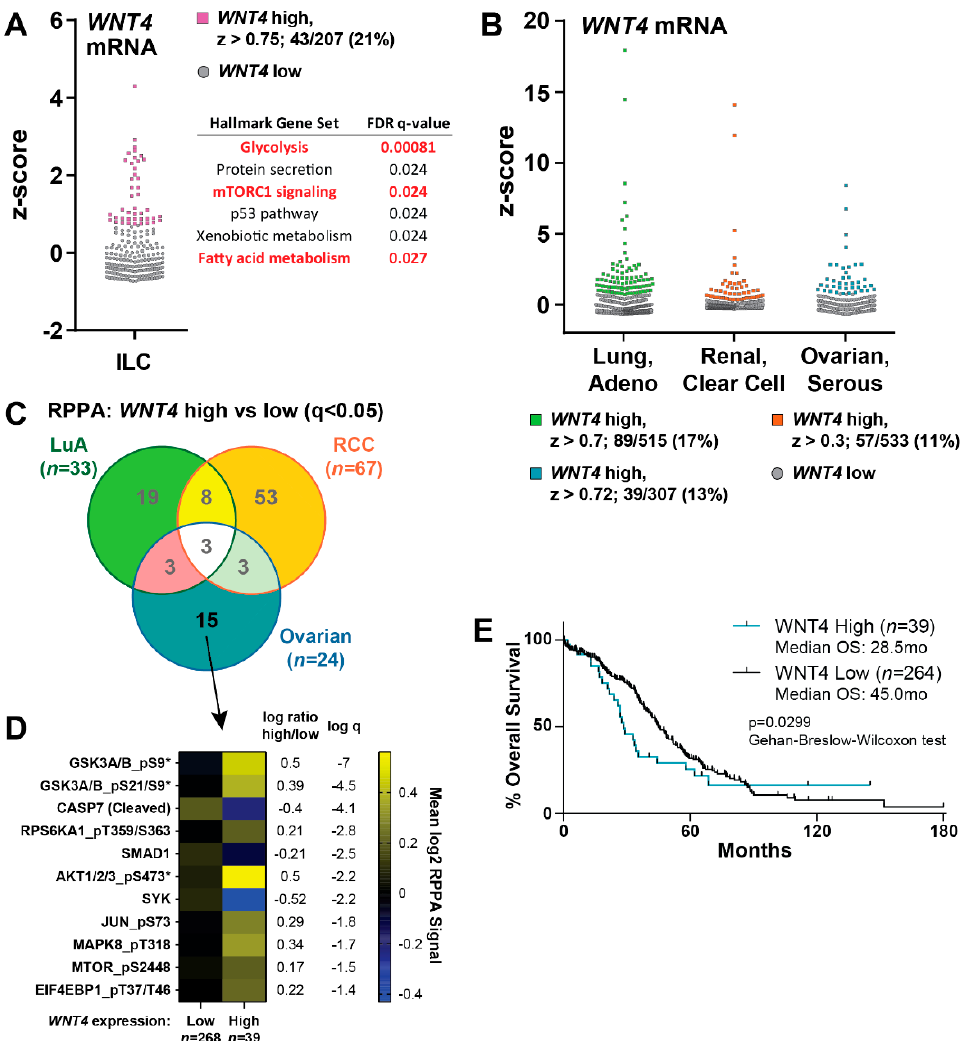
Figure 6. High WNT4 expression is associated with activated mTOR signaling in ILC and serous ovarian cancer. ( A ) RNAseq z-scores used to identify tumors with high WNT4 mRNA levels from The Cancer Genome Atlas (TCGA) data. Points represent individual tumor samples; colored v gray points represent individual tumor samples with high / low WNT4. n = 354 genes di ff erentially expressed in WNT4-high vs. -low tumors were analyzed against the MSigDB “Hallmark” genesets. ( B ) RNAseq z-scores were used to identify WNT4-high vs. -low tumors as in ( A ). ( C ) cBio “Enrichment” tool was used to identify di ff erences in RPPA signals for WNT4-high vs. -low tumors (q < 0.05). ( D ) Mean log2 RPPA signal for WNT4-associated RPPA targets specific to OvCa. *, GSK3A / B and AKT1 / 2 / 3 are counted as individual targets in cBio but do not have unique data ( n = 15 from Venn yields n = 11 unique targets). ( E ) Overall survival data derived from cBio “Survival” tool. High v low WNT4 as in ( B